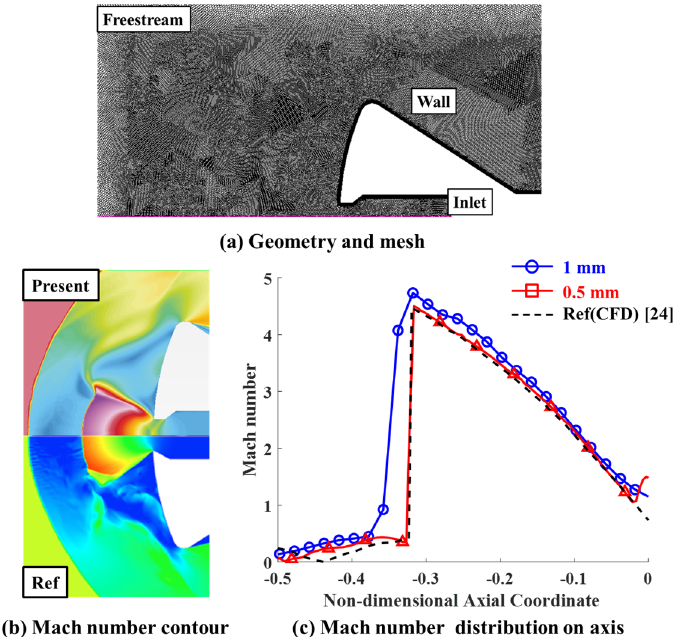
Figure 6. Validation results. ( a ) Geomery and mesh; ( b ) Mach number contour; ( c ) Mach number distribuation on axis.